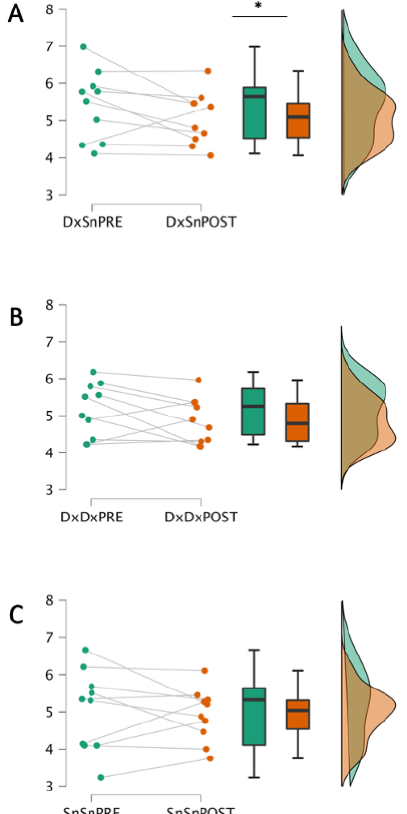
Figure 3. Faremus effects on CST inter-side homology and intra-side recruitment variability. One- sided signed-ranks test on inter-side DxSn ( A ) and intra-side DxDx ( B ); SnSn ( C ) MEP Fréchet distances before (PRE) and after (POST) Faremus treatment. Scale values in logarithmically transformed mV. Only the inter-side homology ( A ) displayed a significant reduction after with respect to before Faremus (* p < 0.05).